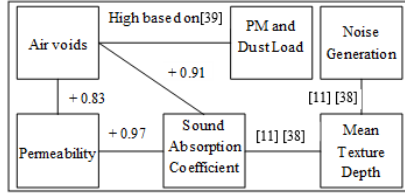
Figure 13: Correlation between main parameters